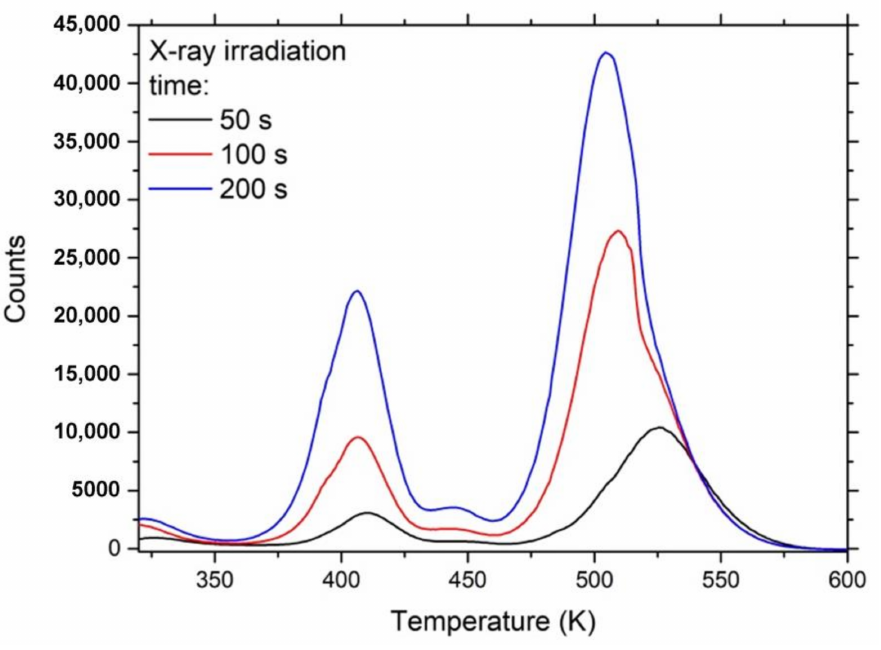
Figure 14. High-temperature thermoluminescence spectra of the 800_50 sample with different irradiation